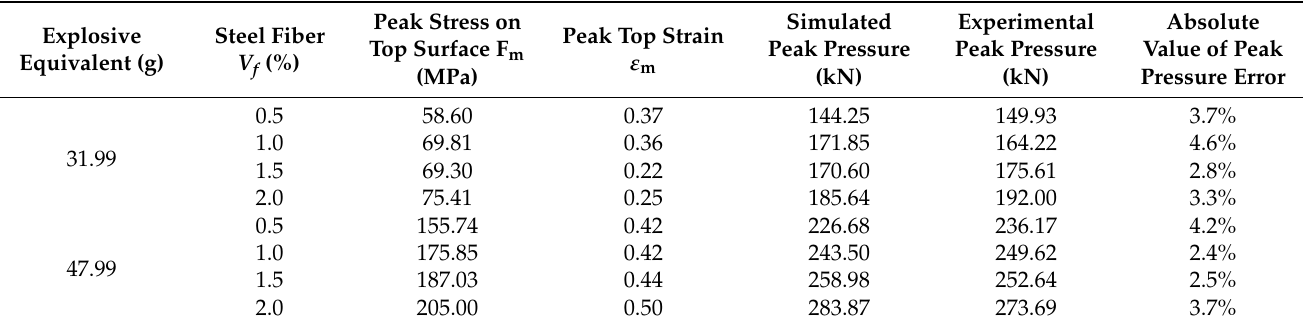
Table 9. Ls-dyna simulation results and experimental comparison of spindle specimens with different steel fiber content.